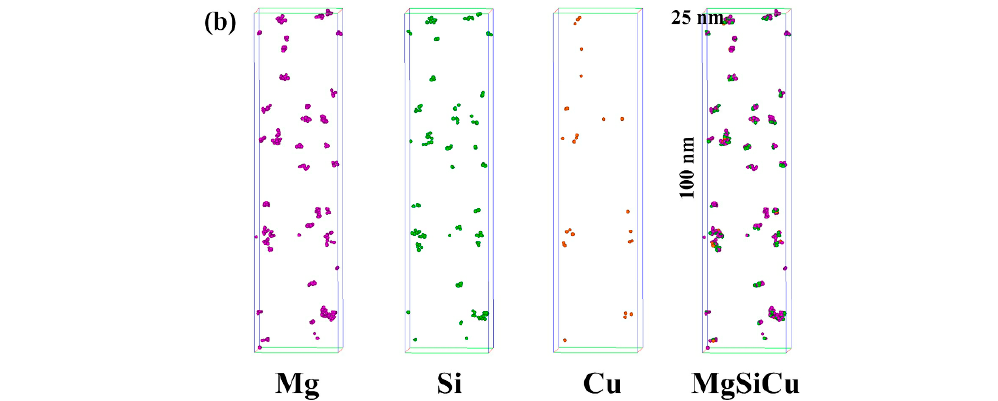
Figure 6. The atom probe tomograghy (APT) maps in S + EA sample: ( a ) Atom distribution maps of different elements in a cube of 55.68 nm × 55.68 nm × 151.78 nm, ( b ) cluster distribution maps of Mg, Si, Cu, and MgSiCu in selected cube of 25 nm × 25 nm × 100 nm. Materials 2019 , 12 , x FOR PEER REVIEW